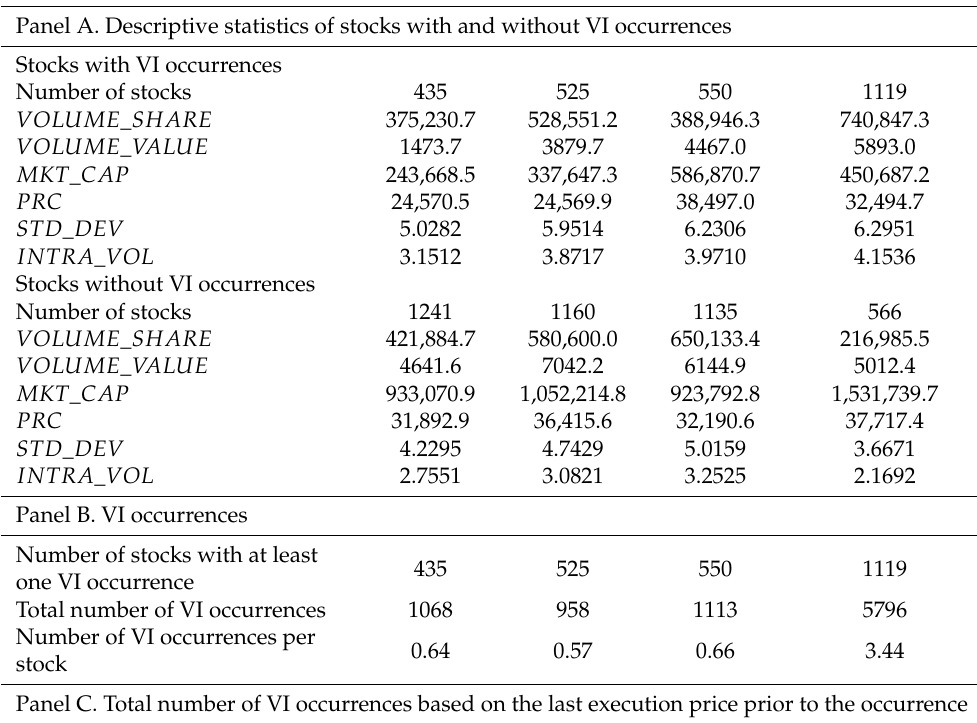
Post Post Dynamic